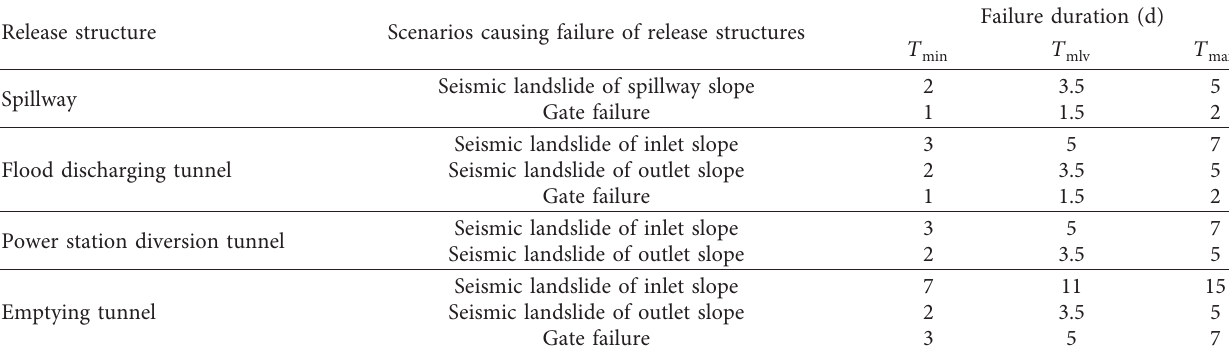
Table 5: Probability distribution parameters for failure duration of release